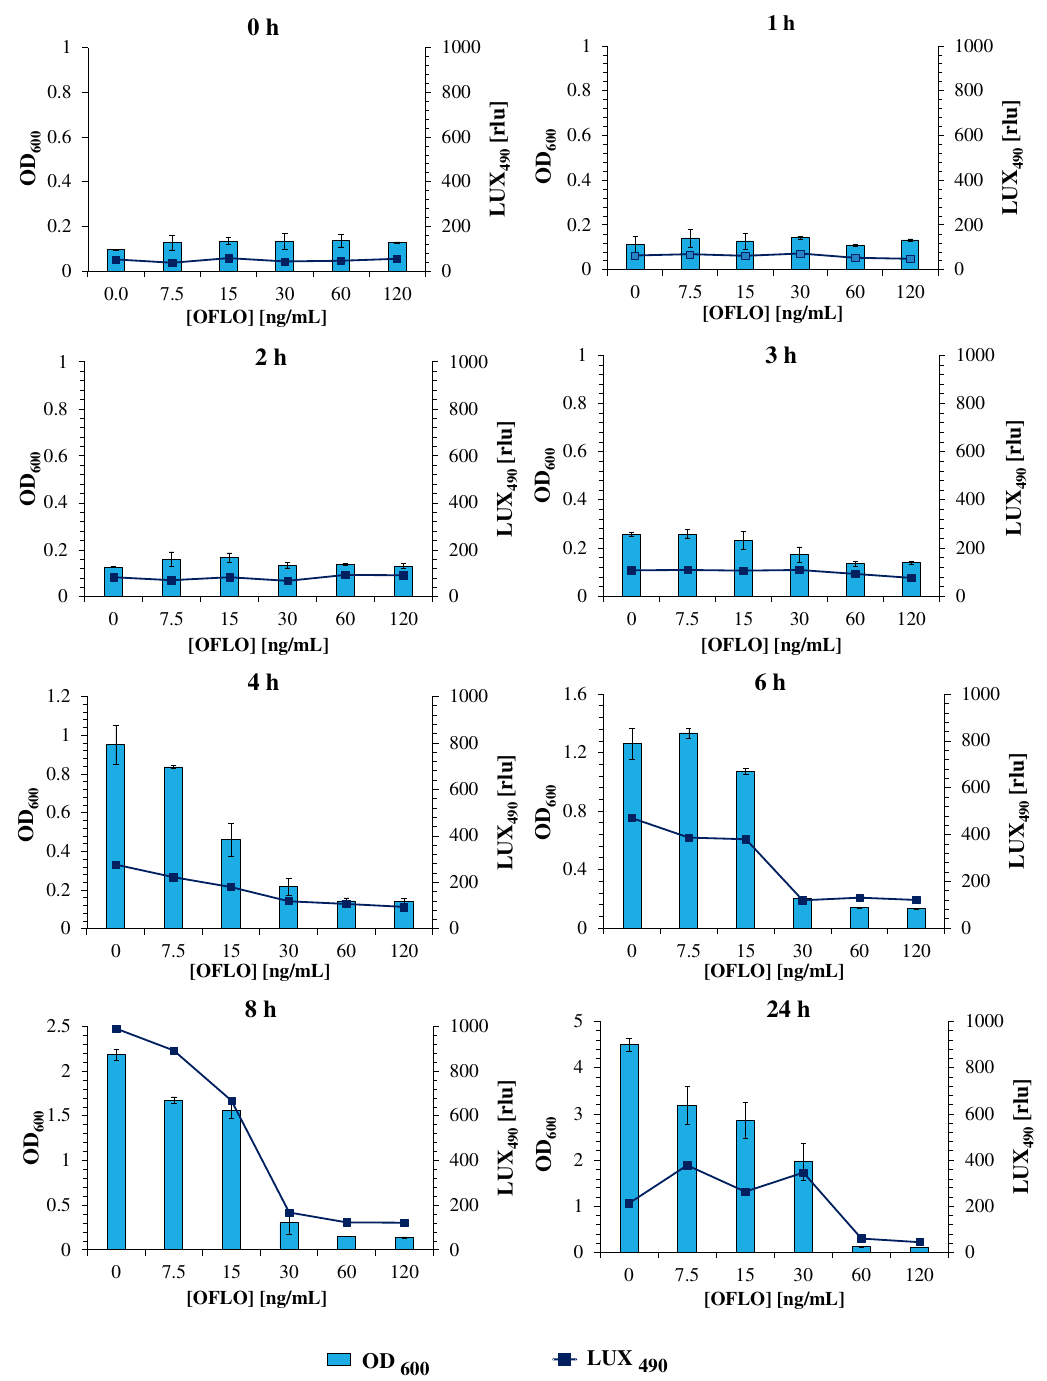
Figure 2. Temporal bacterial response of E. coli Lux to ofloxacin, under static conditions, for different concentrations. Responses were given in the form of LUX 490 signal intensity and OD 600 .